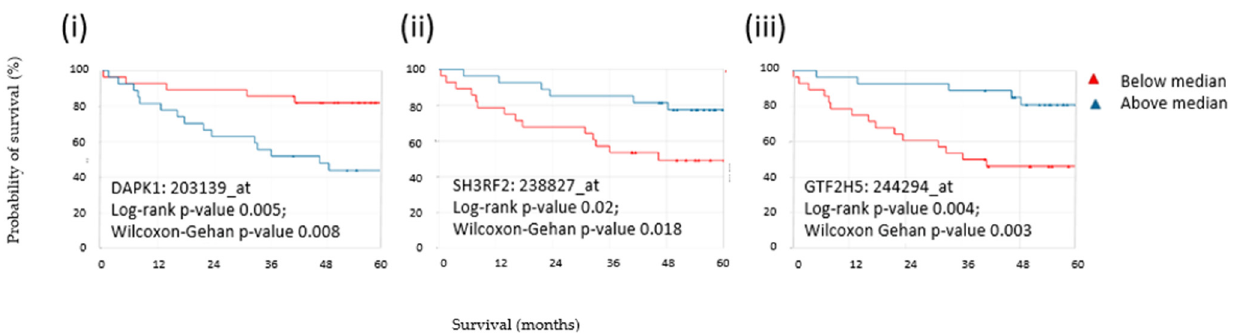
Figure 4. Gene expression analysis was used to determine the impact of above and below median antigen expression on survival during follow-up. The probability of overall survival is shown on the y -axis, while time in months is shown on the x -axis. Below median levels of ( i ) DAPK1 and above median levels of ( ii ) SH3RF2 and ( iii ) GTF2H5 were associated with improved 5-year overall survival in CRC patients.